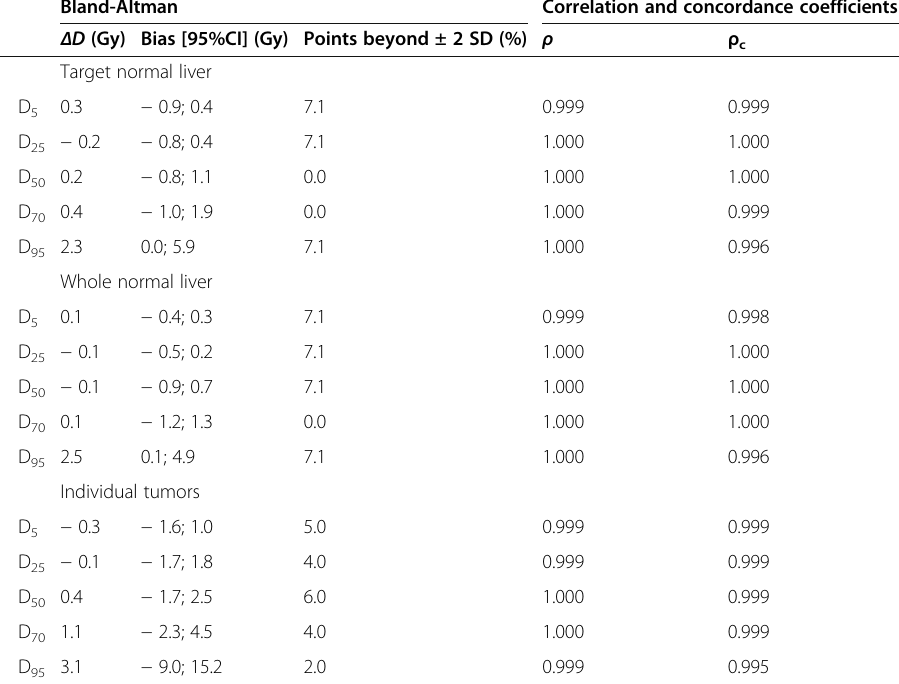
Table 3 Comparison among both 3D dosimetry methods (LDM and DPK) in terms of D 5 , D 25 , D 50 , D 70 , and D 95 delivered to target normal liver, whole normal liver, and individual tumors: Bland Altman analysis and Lin concordance coefficients